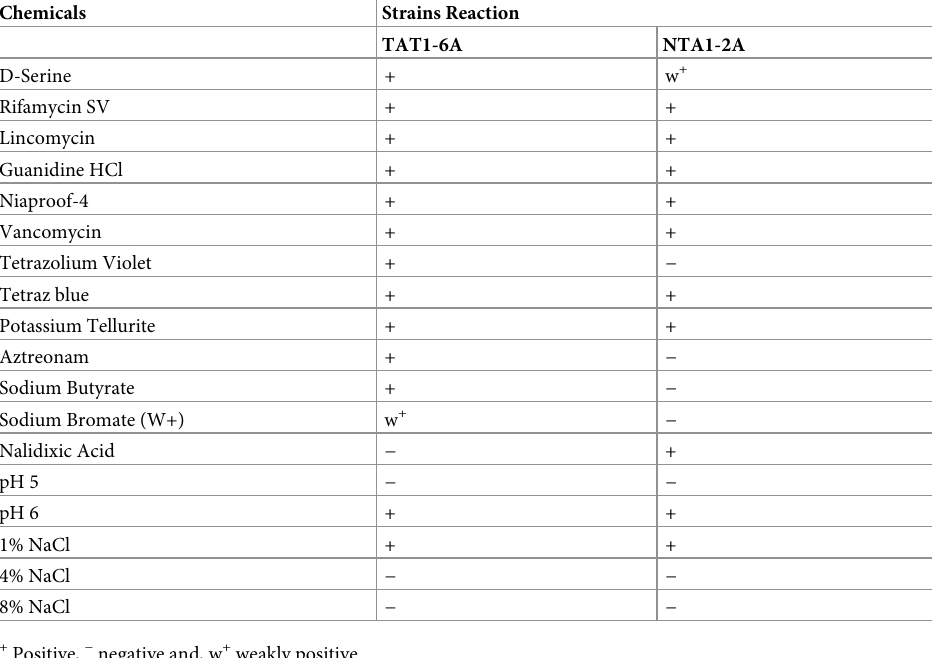
The 16S rDNA gene amplicon products of DNA isolated from strains NTA1-2A and TAT1-6A (1407 bp and 1408 bp, respectively) were sequenced and showed 99% sequence simi- larity with Acinetobacter towneri and Acinetobacter guillouiae homologous genes in GenBank using BLAST. Combining these, our strains NTA1-2A and TAT1-6A identified as Acinetobacter towneri and Acinetobacter guillouiae on the basis of 16S rRNA gene sequencing. The 16S rRNA gene sequences of the strains NTA1-2A and TAT1-6A have been deposited in NCBI database under the GenBank accession numbers of KY411880 and KY411879. Phylogenetic analysis showed that strain NTA1-2A and TAT1-6A fell within other members of Acinetobacter near Table 2. Chemical sensitivity of strains NTA1-2A and TAT1-6A strains using GEN III MicroPlate identification tool.